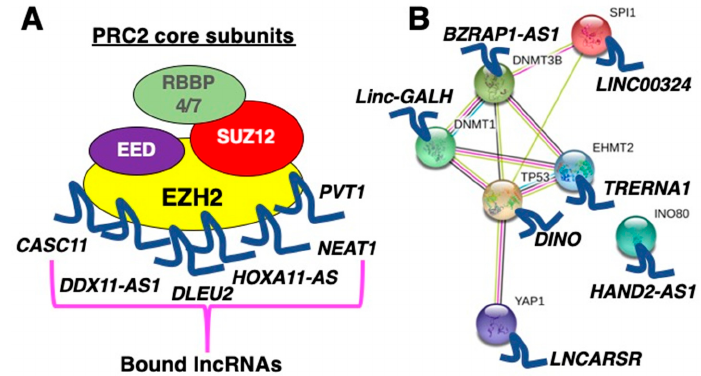
Figure 1. Molecular mechanism of long non-coding RNAs (lncRNAs). ( A ) A growing list of